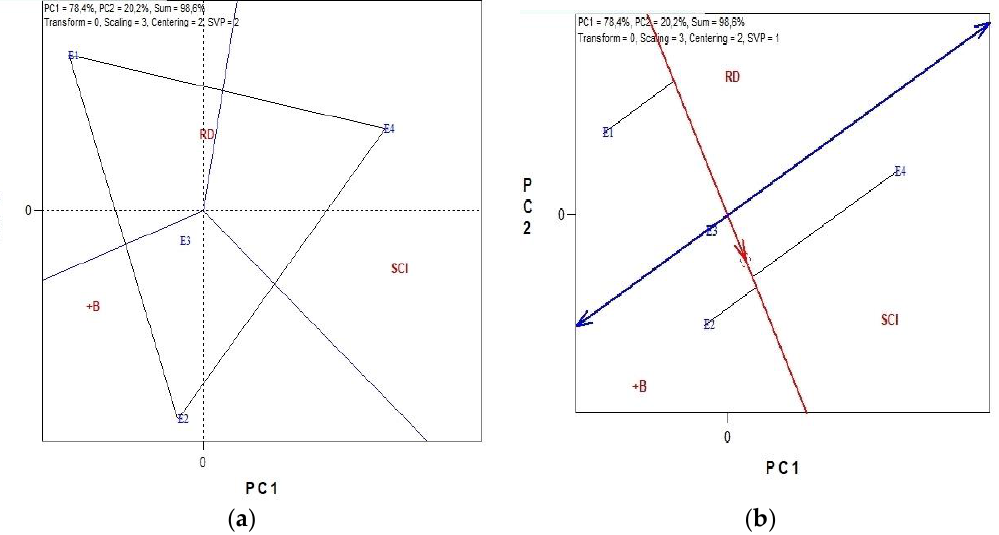
Figure 3. ( a , b ) . Biplot analysis of reflectance (Rd), yellowness (+b), and spinning consistency index (SCI), cotton measurements across four environments.